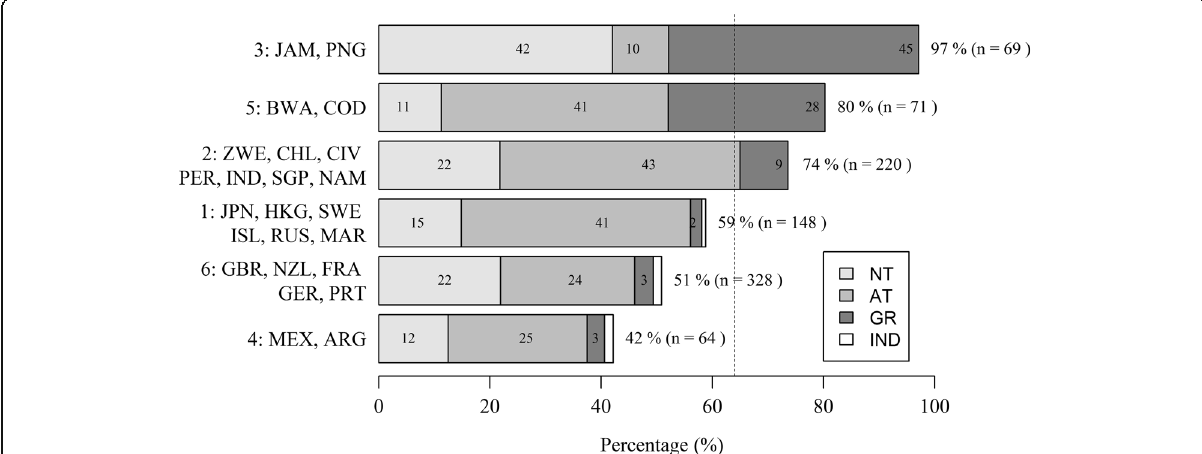
Fig. 4 Percentage of players (%) for each country cluster who sustained an injury that they believed was caused by the pitch (Q4.1.1) (order highest to lowest total %) grouped by the type of surface used at the time of injury (Q4.1.1.1) and expressed as a percentage of all responses to Q4.1.1. The dashed line (64%) represents the mean of all players who responded yes to Q4.1.1.